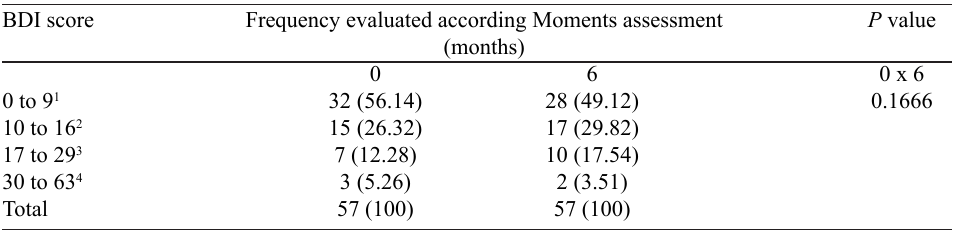
Table 2. Frequencies of distribution of depressive symptoms using the test Wilcoxon in patients undergoing coronary artery bypass grafting at different time points. São Luís - MA, 2013.